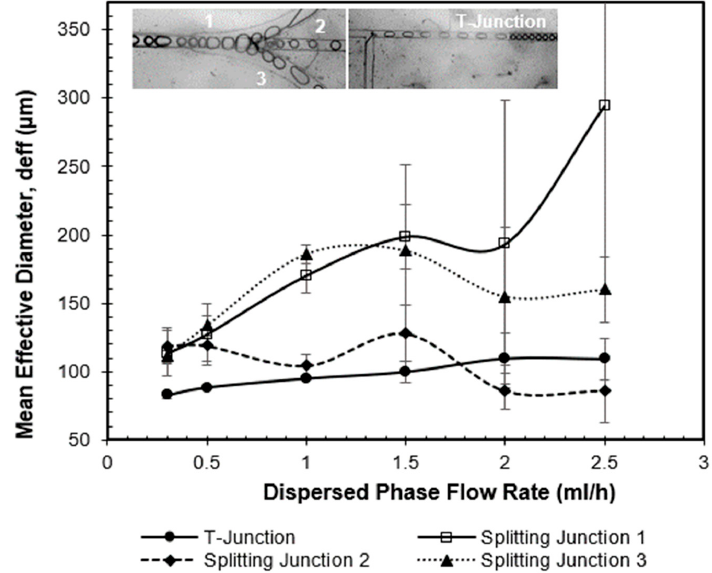
Figure 12. Average droplet size distribution with respect to di ff erent Q d ranging from 0.3 to 2.5 mL / h in symmetrical bifurcating junction. Image indicates the region of interest for the droplet measurement. Error bars indicate the standard deviation in e ff ective droplet size measurement of 30 droplets under fixed experimental condition.